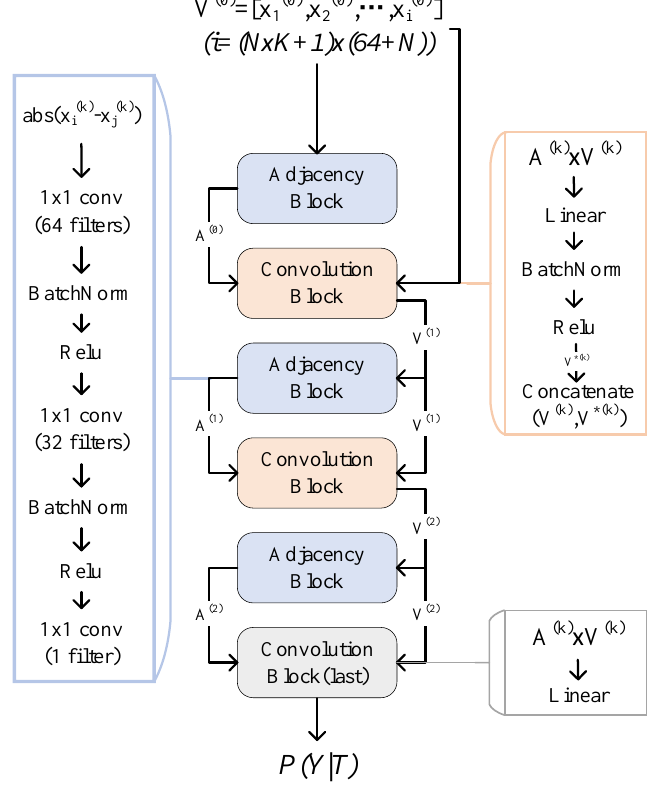
Figure 5. The architecture of the GNN model.